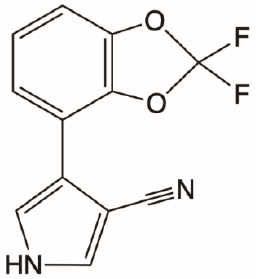
Figure 1. Chemical structures of fludioxonil.